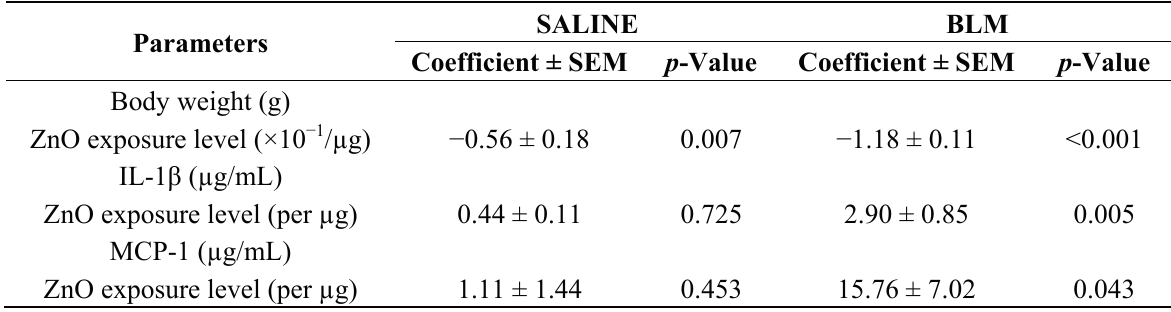
Table 2. The coefficient of the regression line analysis for the SALINE and BLM groups at Day 10 after administration. SEM, standard error of the mean; IL-1 β , interleukin-1 β ; MCP-1, monocyte chemotactic